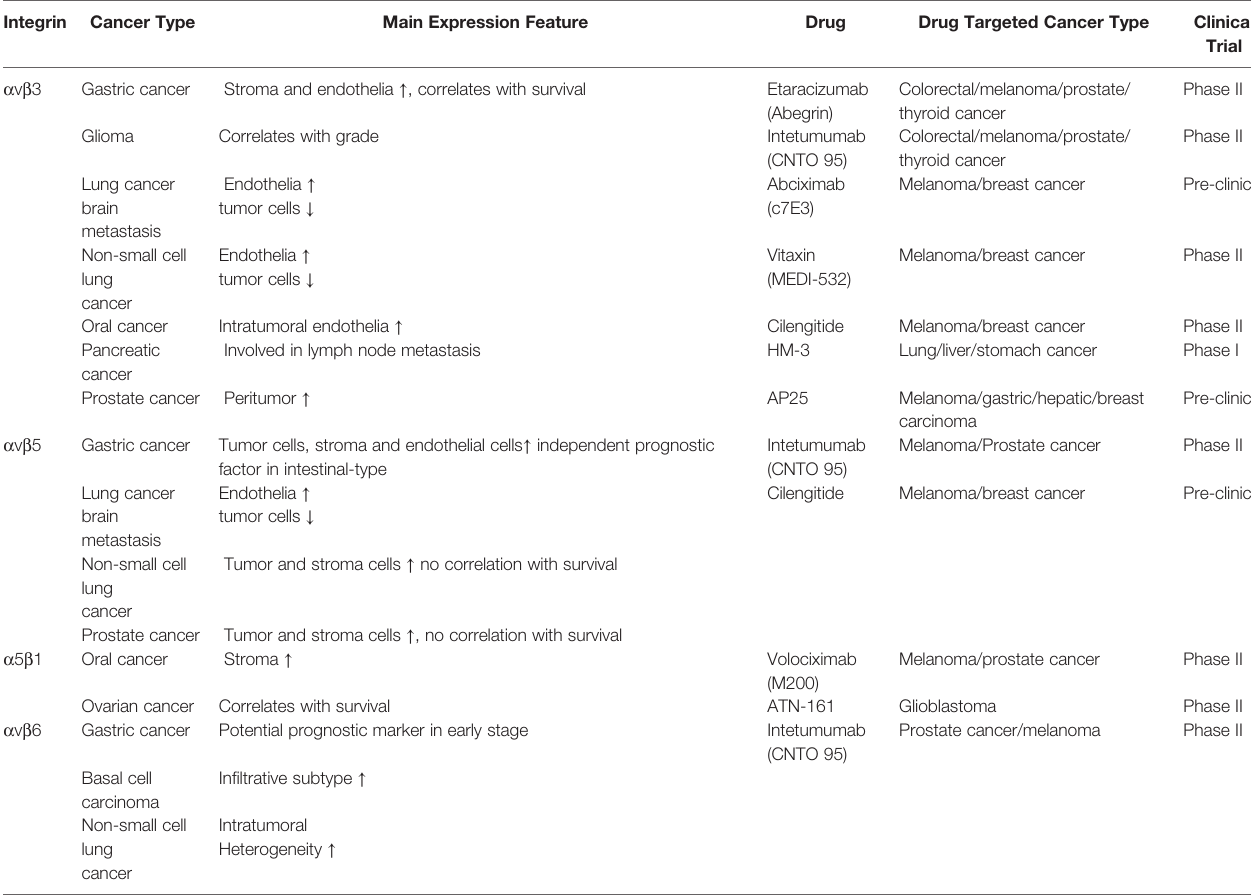
TABLE 2 | a v-integrins expressed in different human cancers and their pre-clinical antagonists. Integrin Cancer